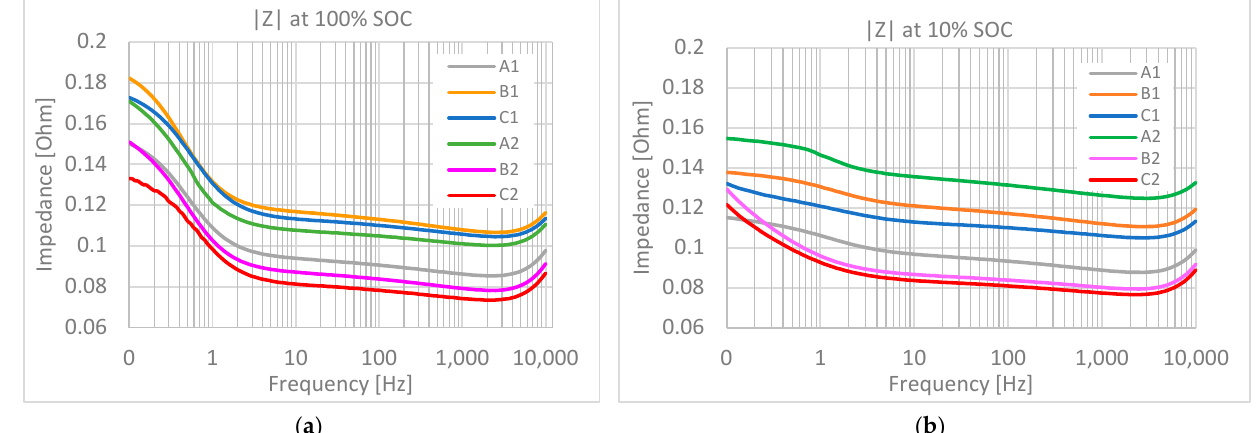
Figure 4. Impedance measurements: ( a ) at 100% SOC and ( b ) at 10% SOC.